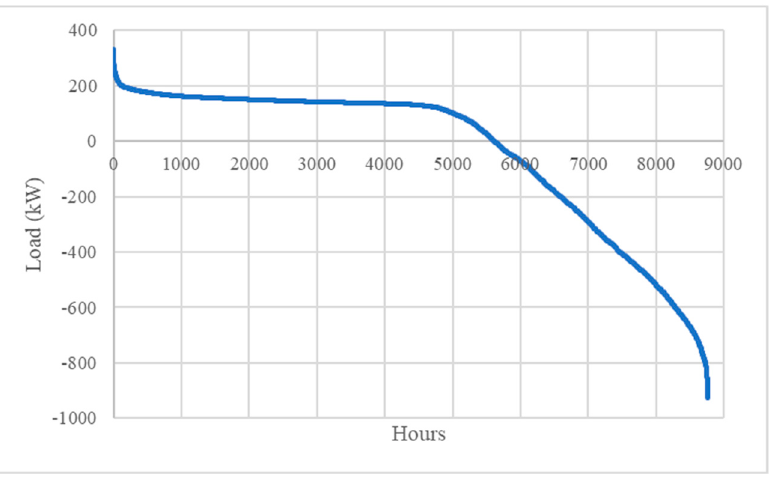
Figure 11. Load duration curve that refers to an external transformer in the HMU campus microgrid (optimal autoproducer case solution).